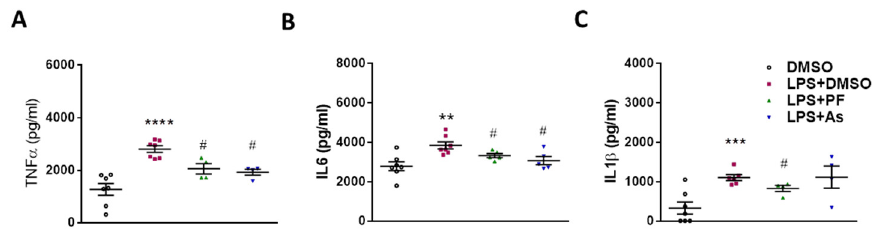
Figure 10. Inhibition of ATX and LPA5 downregulates peripheral cytokine concentrations in LPS-injected C57Bl/6 mice. Mice (n = 6–8 per group) were injected i.p. with DMSO, LPS (5 mg/kg) plus DMSO, with or without PF8380 (‘PF’; 30 mg/kg) or AS2717638 (‘AS’; 10 mg/kg). After 24 h, the animals were sacrificed, blood was collected and processed to obtain serum. Serum was diluted at 1:10 for further analysis. ( A–C ) The concentrations of TNF α , IL6 and IL-1 β were quantified using ELISA. Values are expressed as mean ± SEM of 6–8 mice per group ** p < 0.01, *** p < 0.001, **** p < 0.0001 compared to DMSO control; # p < 0.05 compared to LPS-treated mice; one-way ANOVA with Bonferroni correction).